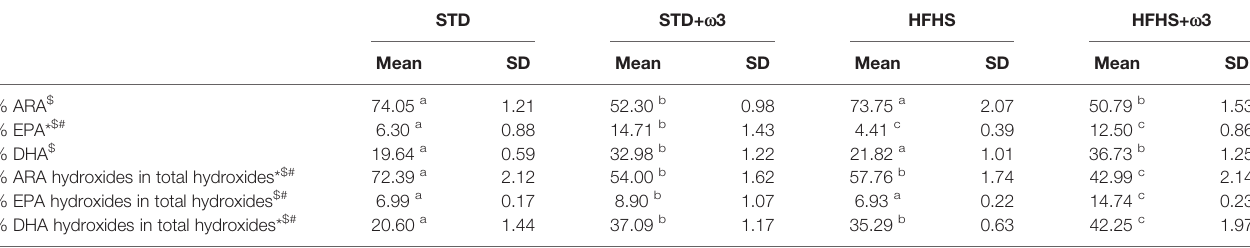
TABLE 5 | Percent distribution of ARA, EPA and DHA in total PUFAs present in adipose